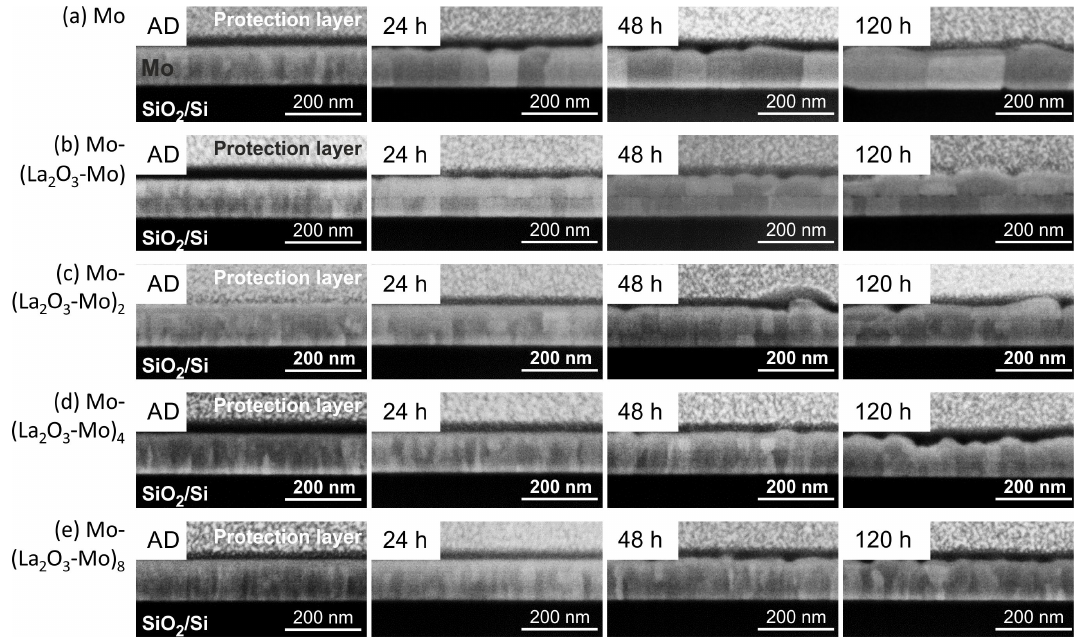
Figure 4. SEM micrographs (inLens, 20 keV) of FIB cross-sections of the Mo-(La 2 O 3 -Mo) n multilayer systems on SiO 2 /Si in the as-deposited state (AD) and after thermal treatment in high vacuum for different time durations at 800 ◦ C ( a ) pure Mo, ( b ) Mo-(La 2 O 3 -Mo), ( c ) Mo-(La 2 O 3 -Mo) 2 , ( d ) Mo-(La 2 O 3 -Mo) 4 and ( e ) Mo-(La 2 O 3 -Mo) 8 . For FIB cross-sectioning the samples were covered